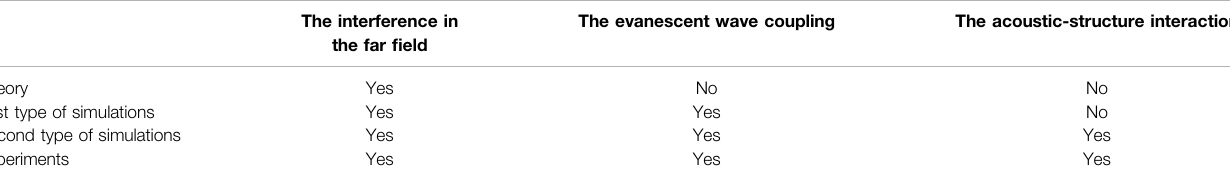
TABLE 4 | The coupling effects that each model takes into account. By comparing the corresponding curves in Figure 6 , the evanescent wave coupling and the acoustic- structure interaction can be separately evaluated for the validation of the assumptions that are made in the Theoretical Model for Supercell With Different Unit Cells